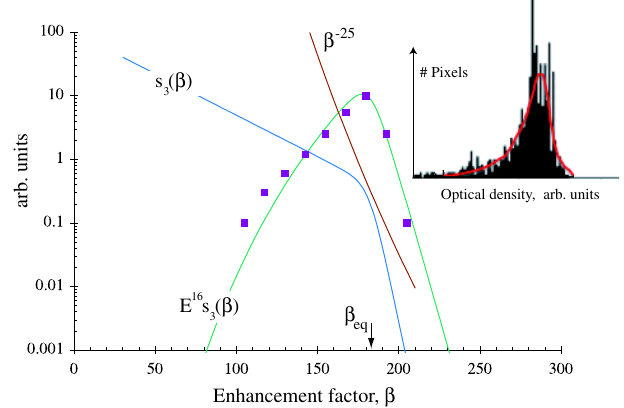
FIG. 7. (Color) The equilibrium emitter enhancement spectrum (cid:4) (cid:1) (cid:7) is plotted against (cid:1) , along with the observed spectrum s 3 multiplied by the Fowler-Nordheim emission factor, E 16 s value, and the slope of the cutoff which the equilibrium (cid:1) eq approximately goes like (cid:1) (cid:11) 25 . Data from the optical density measurements of Fig. 6, is shown as an inset, with a fitted line, and values from this line are shown as squares on the plot. As noted in the text, there is an uncertainty about the absolute horizontal calibration of the optical density data.